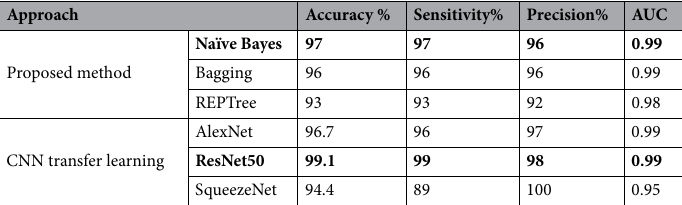
Table 4. Summary of performance metrics. Significant values are in [bold].